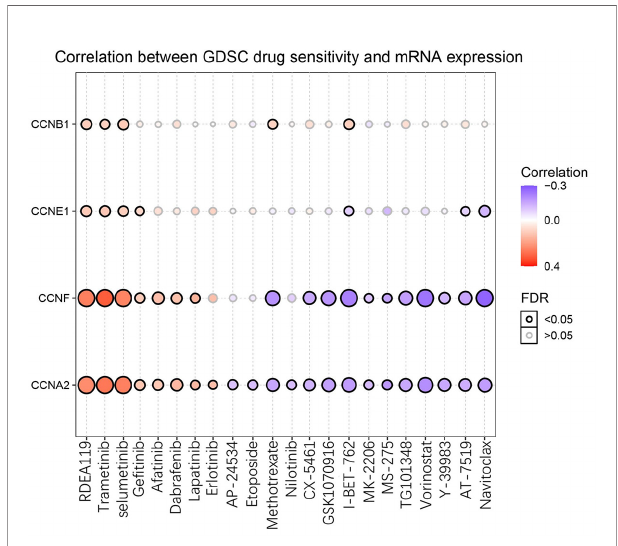
FIGURE 13 | Drug sensitivity of the four signi fi cant cyclin genes from GSCA. The bubble plot exhibits the correlations between the gene expression and FDA-approved drugs. The positive Spearman correlation coef fi cients indicate that high gene expression is resistant to the drug, and vice versa . GDSC, Genomics of Drug Sensitivity in